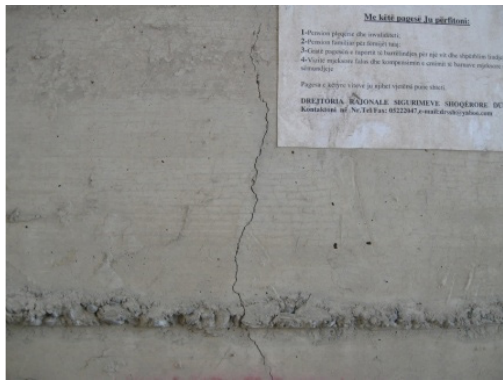
(c) Plastic shear crack at